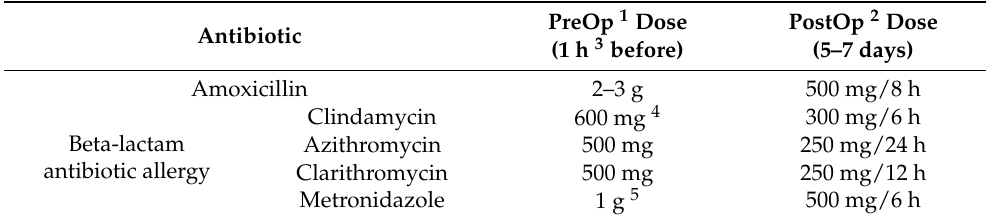
Table 5. Recommended doses in the placement of immediate implants with or without the presence of chronic infection of the tooth to be